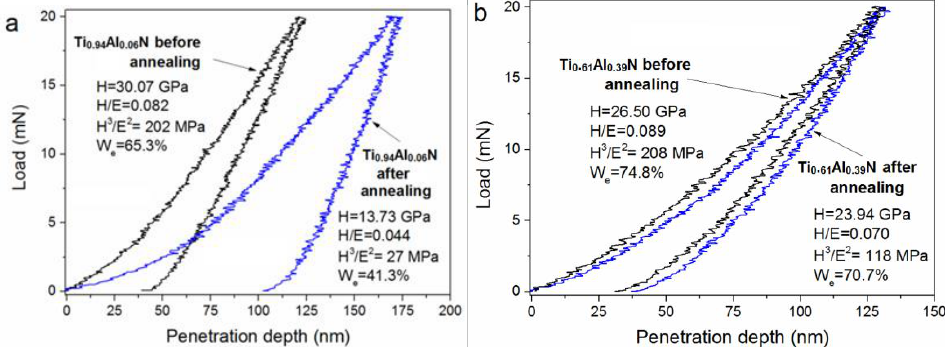
Figure 10. Loading – unloading curves obtained after the nanoindentation of the Ti 0.94 Al 0.06 N ( a ) and Ti 0 . 61 Al 0.39 N ( b ) coatings before and after annealing at 700 °С.